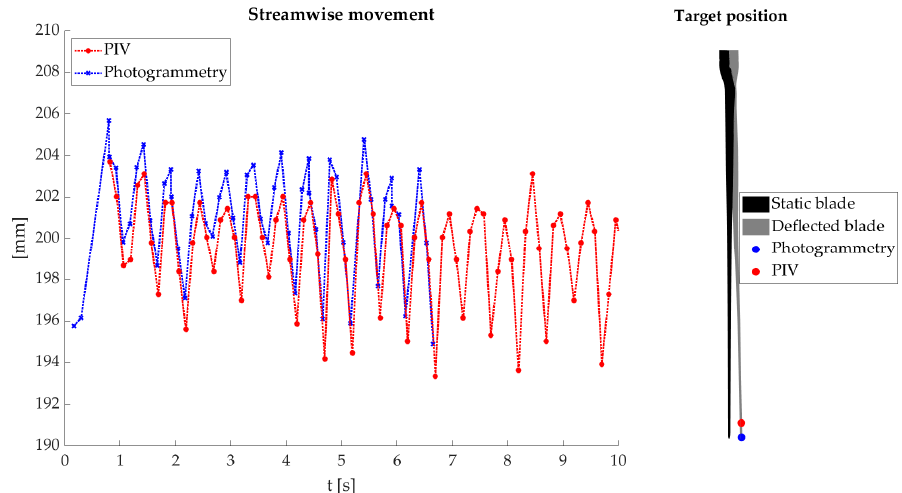
Figure 15. Deflection comparison with PIV system ( left ). Different target positions lead to a different X-axis position ( right ). X-axis position ( right